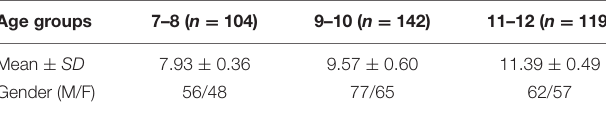
TABLE 1 | Demographic characteristics of the